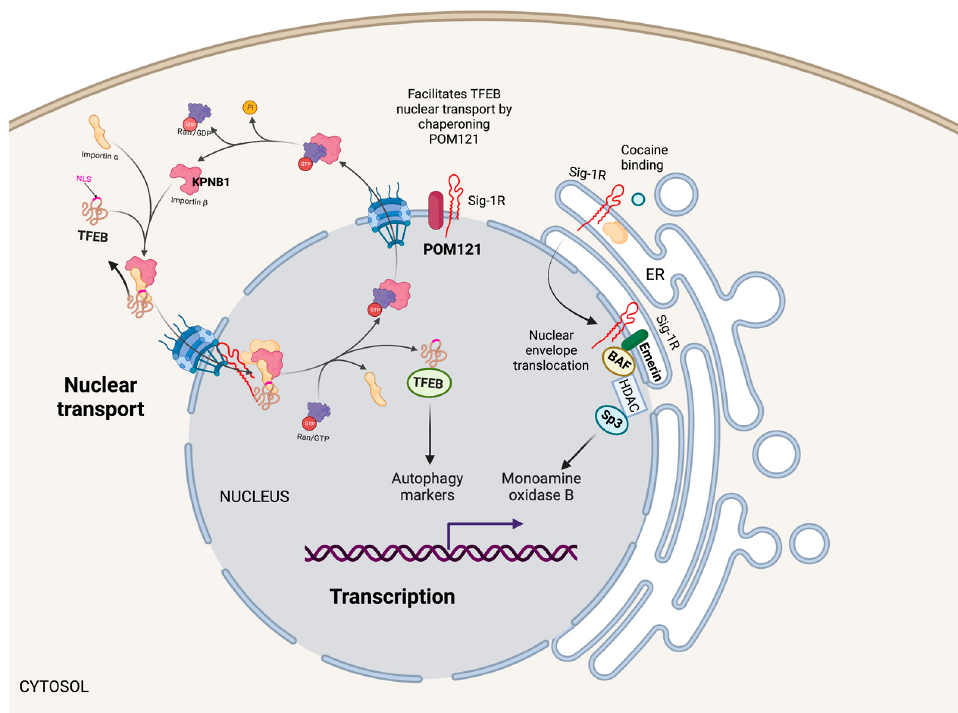
Figure 4. Nuclear Sig-1R signaling pathways. Sig-1R localizes in the nuclear envelope and inside the nucleus to regulate nuclear functions. For example, Sig-1R increases monoamine oxidase B transcrip- tion by forming a Sig-1R/Emerin/BAF/HDAC/SP3 complex that binds to its promoter. Additionally, Sig-1R facilitates the nuclear transport of TFEB through the nuclear pore by chaperoning POM121, a nucleoporin that recruits KPNB1, influencing